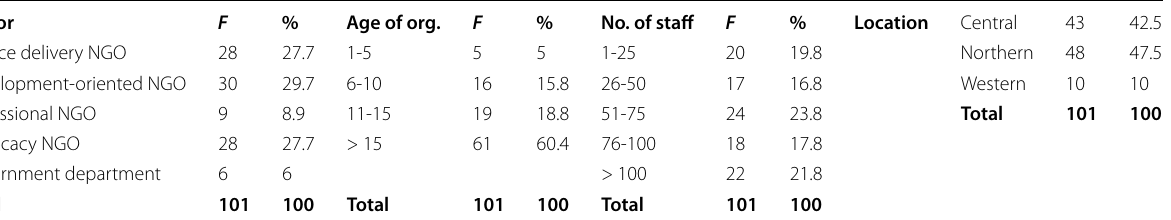
Table 8 Humanitarian organisations characteristics